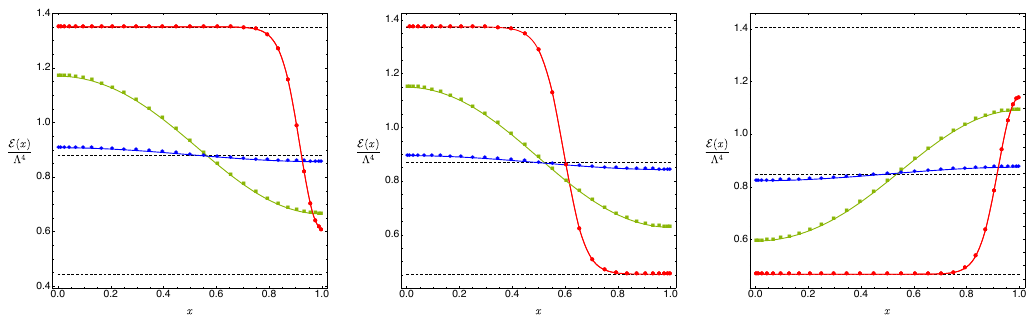
Figure 12 . Energy density profile ˆ E ( x ) for three lumpy branes at the same temperature ˆ T . 14 (Left) Lumpy branes at constant ˆ T ’ 0 . 394948 (this is the first vertical line of orange circles to the left of C in figure 11). For reference, at the merger the lumpy brane with this temperature has ˆ L = ˆ L ’ 4 . 808993 and ˆ L (cid:7) ’ 4 . 819793 , ˆ L (cid:4) ’ 5 . 996993 , ˆ L • ’ 37 . 208993 . For this temper- GL ature the heavy, intermediate and light uniform branes have energy densities ˆ E heavy ’ 1 . 350615 , ˆ E inter ’ 0 . 881537 and ˆ E light ’ 0 . 443756 , respectively. These energy densities are indicated by the dashed horizontal lines in the plot. (Middle) Lumpy branes at constant ˆ T ’ 0 . 395894 . ˆ T c (so, very close to ˆ T c ’ 0 . 3958945 ). For reference, ˆ L = ˆ L ’ 4 . 750995 and ˆ L (cid:7) ’ 4 . 761845 , ˆ L (cid:4) ’ 5 . 944495 , GL ˆ L • ’ 46 . 523495 , and the energy densities of the relevant uniform branes (dashed horizontal lines) are ˆ E heavy ’ 1 . 373843 , ˆ E inter ’ 0 . 867966 , ˆ E light ’ 0 . 452747 . (Right) Lumpy branes at constant ˆ T ’ 0 . 397308 (this is the first vertical line of orange circles to the right of C in figure 11). For reference, at the merger the lumpy brane with this temperature has ˆ L = ˆ L ’ 4 . 716232 and GL ˆ L ˆ L ˆ L (cid:7) ’ 4 . 727157 , (cid:4) ’ 5 . 917982 , • ’ 34 . 759982 , and the energy densities of the relevant uniform branes (dashed horizontal lines) are ˆ E heavy ’ 1 . 407521 , ˆ E inter ’ 0 . 848014 , ˆ E light ’ 0 . 467119 .